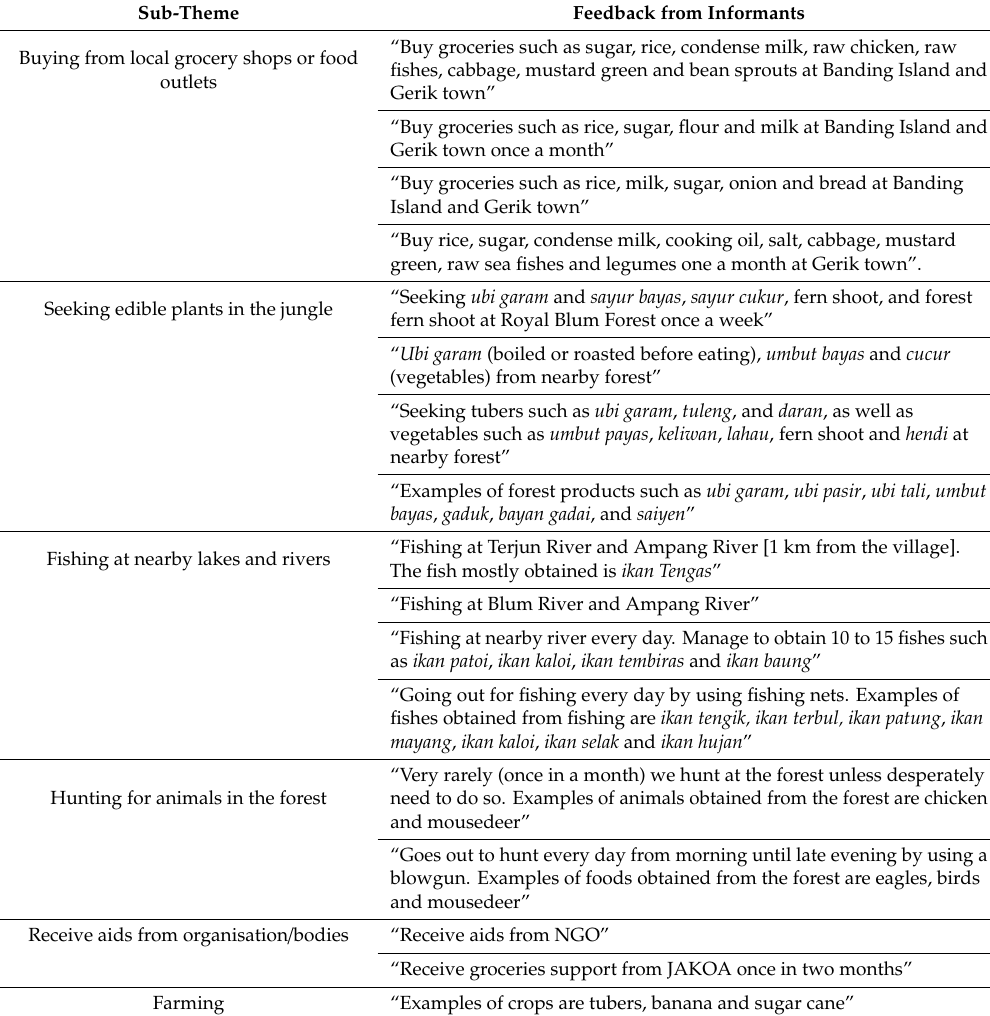
Table 2. Sub-themes of techniques used to obtain foods and feedback from